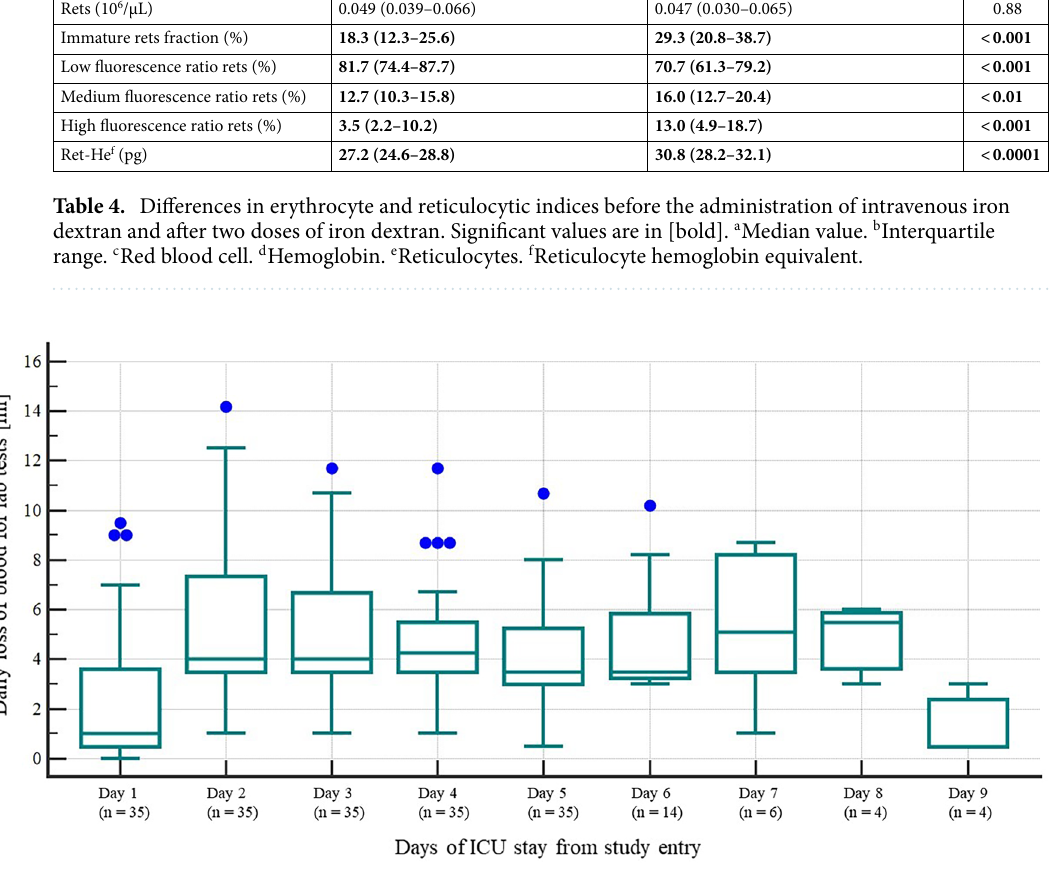
Figure 3. Daily blood volume lost for laboratory diagnostics in the study